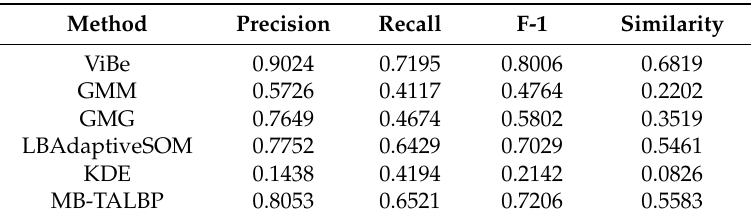
Table 5. Comparison of indexes of “Big